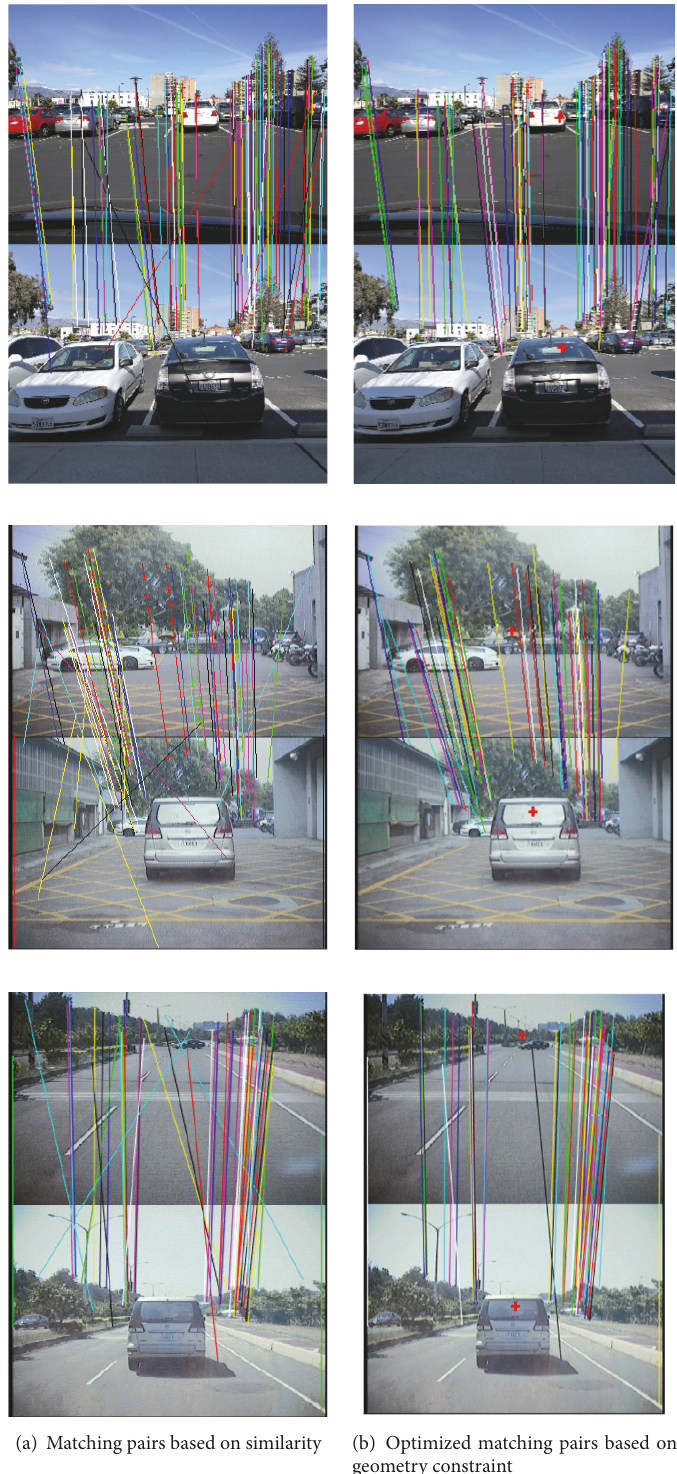
Figure 7: Matching pairs features between front and back